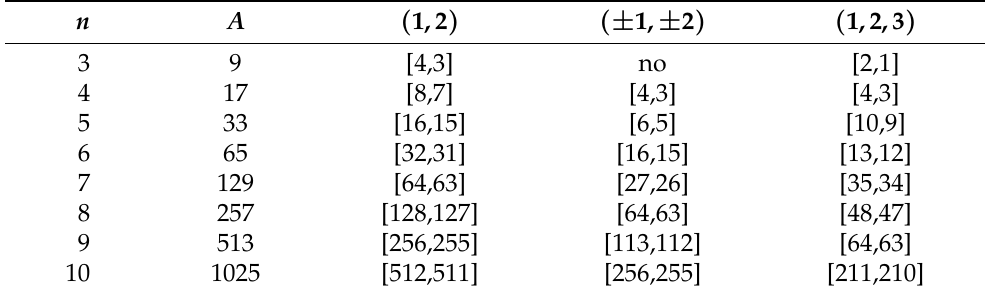
Table 1. Single ( 1,2 ) , ( ± 1, ± 2 ) , or ( 1,2,3 ) errors correctable codes over A = 2 n +